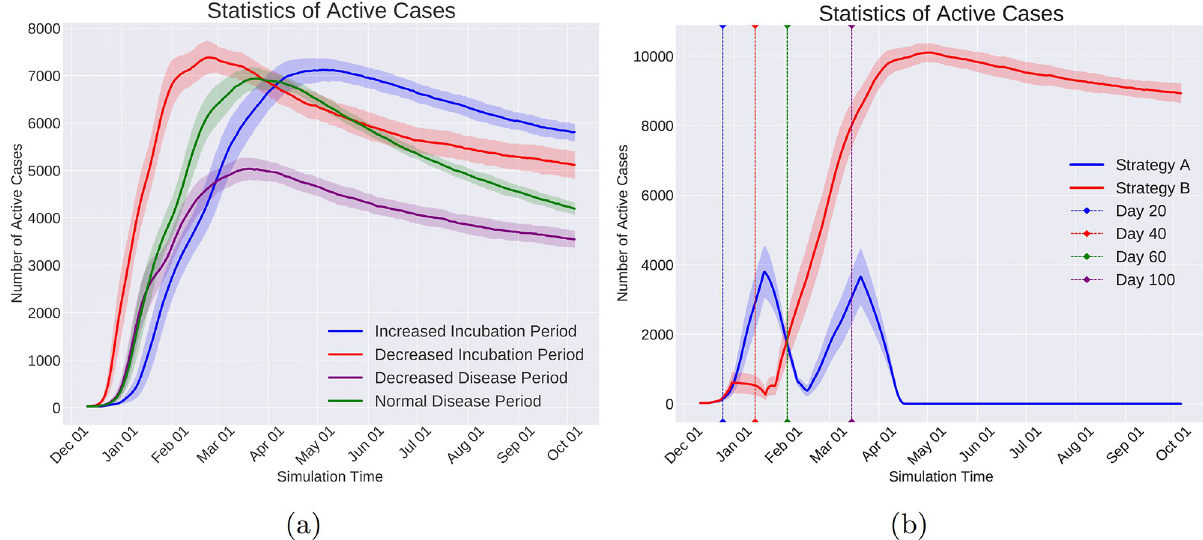
Fig 12. a) The effect of the length of the incubation period (the period in which the infection is not detectable) and the disease period (the period in which the individual is infectious) is shown by changing these parameters of the disease. The curves correspond to a normal incubation and disease period, an increased incubation period by 3.5 days, a decreased incubation period by 3.5 days, and a decreased disease period by seven days. b) The outcome of two quarantine strategies. Strategy A: Enforce a quarantine 40 days after the outbreak, lift it after 20 days and enforce it again after 40